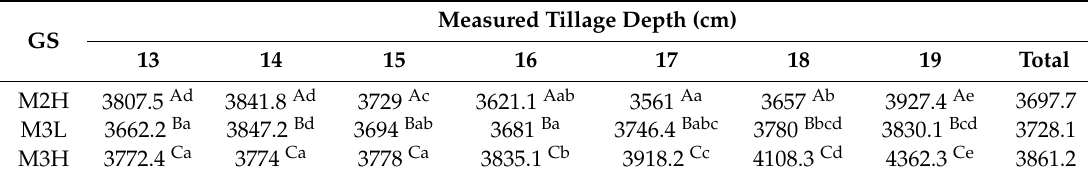
Table 11. Mean front axle torque (Nm) according to the tillage depth and gear selection (GS).